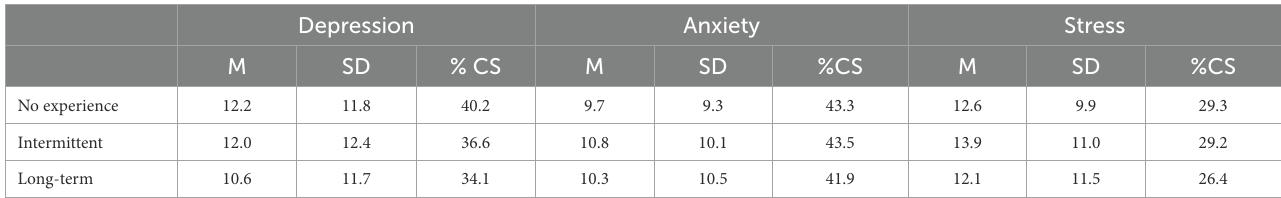
TABLE 5 DASS-42 results and clinical interpretation.